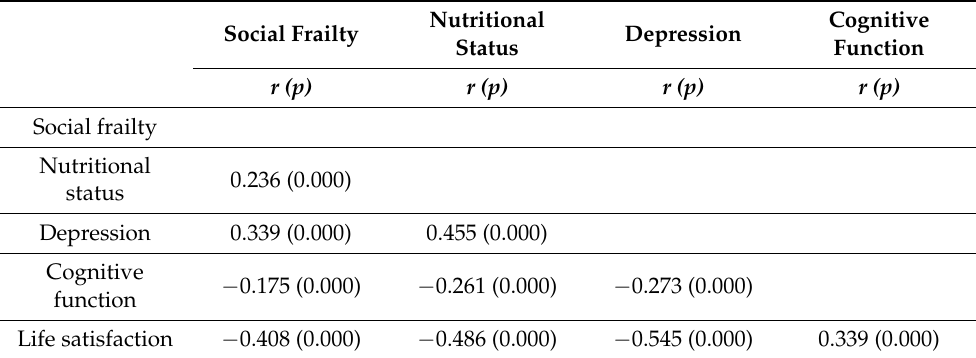
Table 3. Correlations between predictors and life satisfaction.